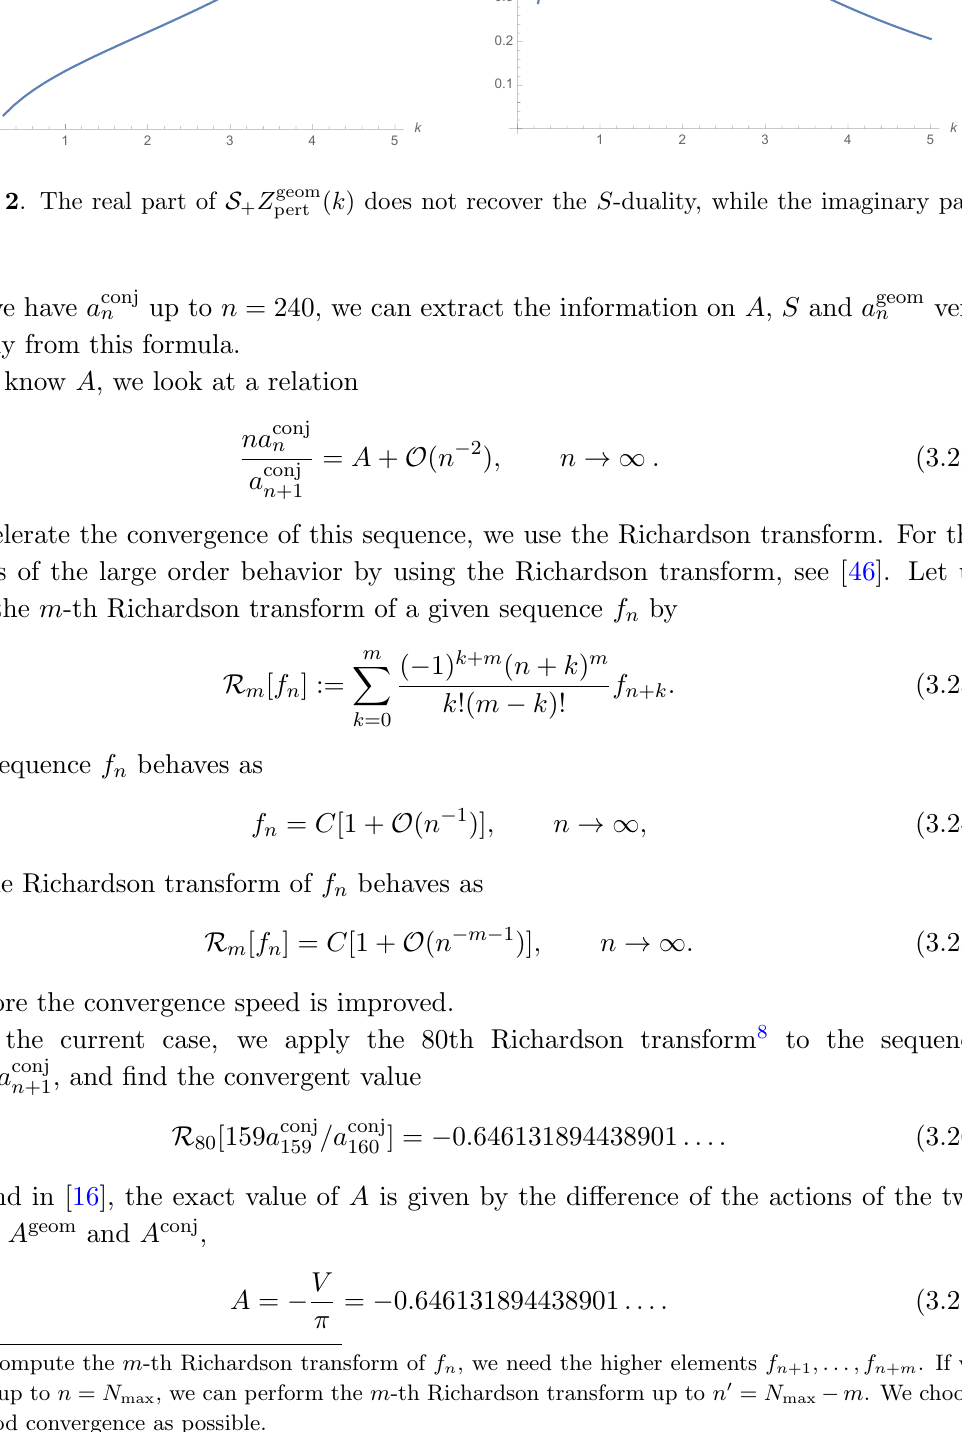
Figure 2 . The real part of S + Z geom